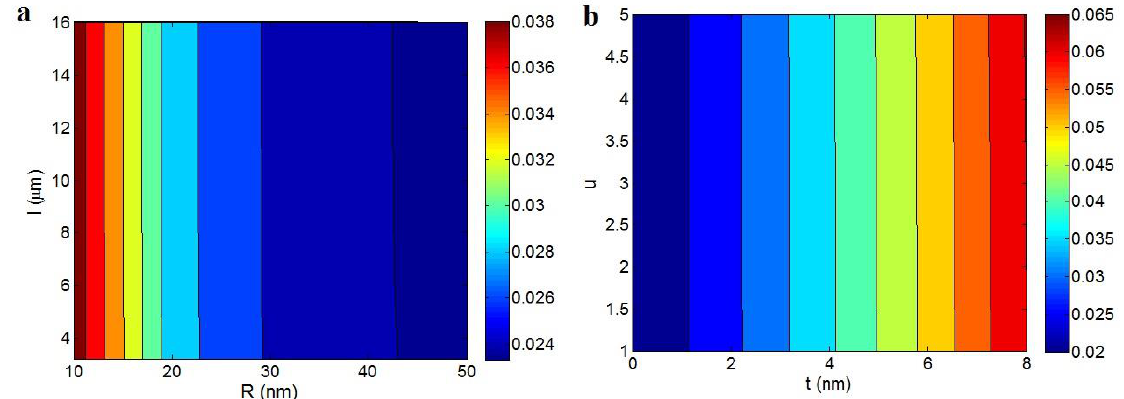
Figure 2. “ ϕ ” (Equation (4)) as a function of ( a ) “R” and “l” and ( b ) “t” and “u”  ” (Equation (4)) as a function of ( a ) “R” and “l” and ( b ) “t” and “u” factors. ef f Figure 2. “ eff